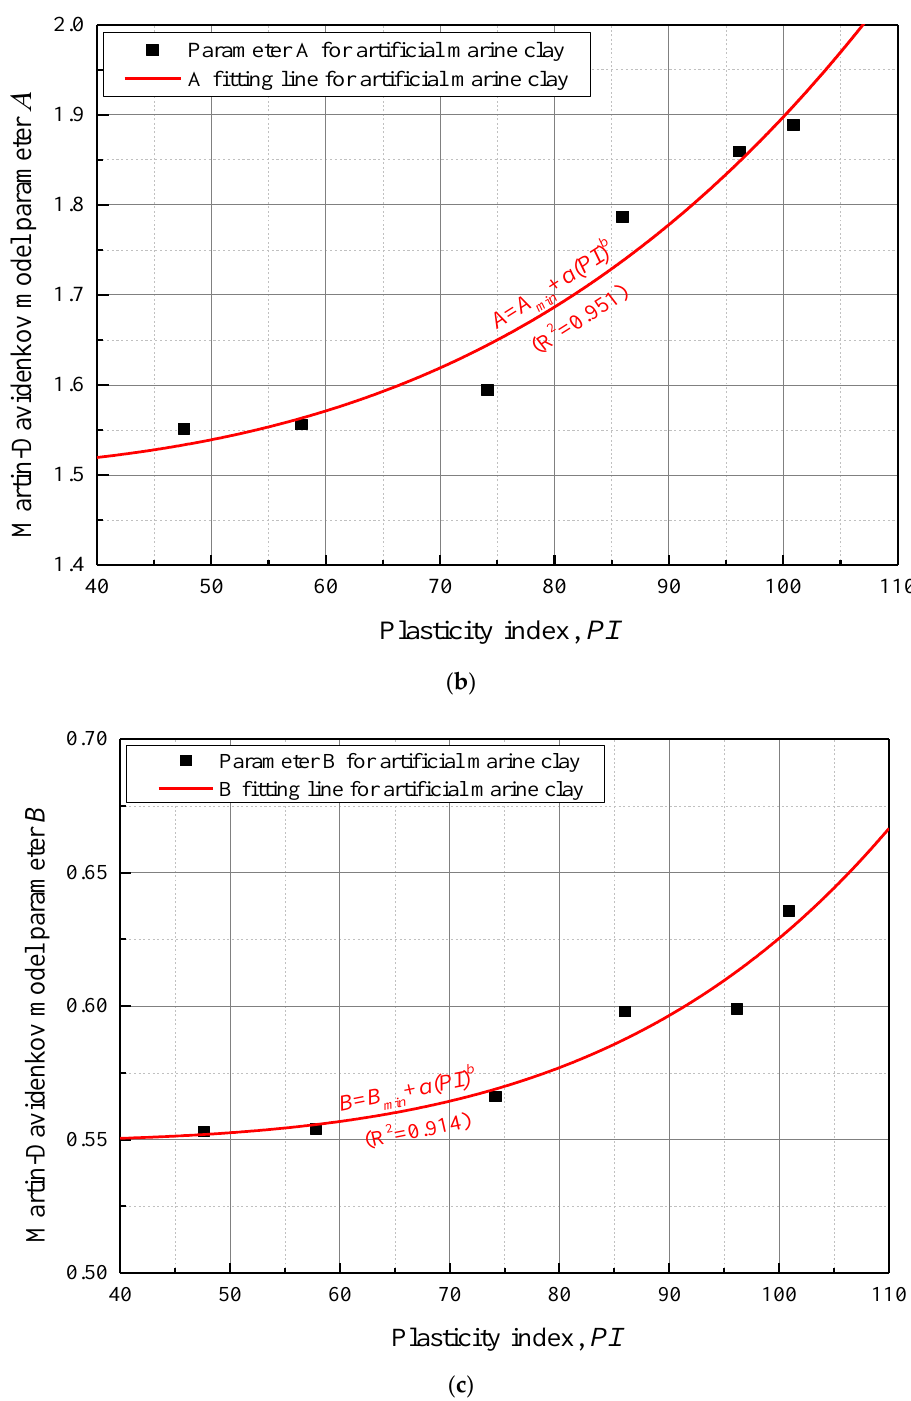
Figure 12. Relationship between plasticity index and Martin–Davidenkov Model parameter curves for mineral composition of artificial marine clays: ( a ) shear strain parameter, γ 0 ; ( b ) parameter A ; ( c ) parameter B